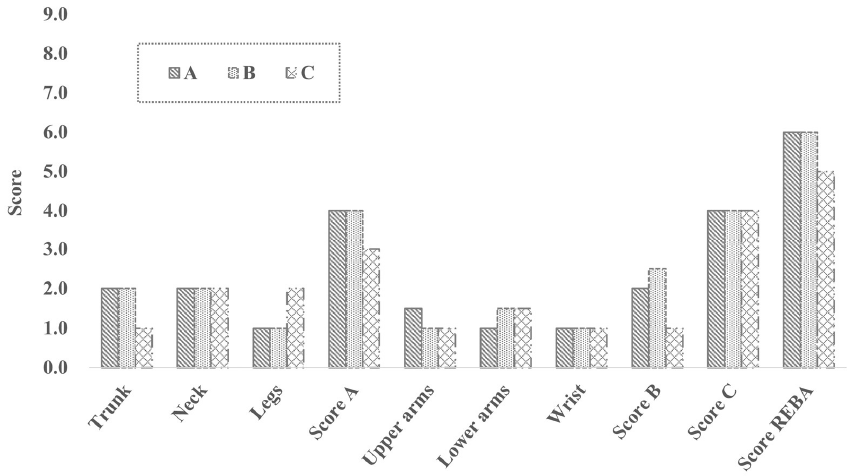
Figure 25. Precision evaluation results of chisel working posture.